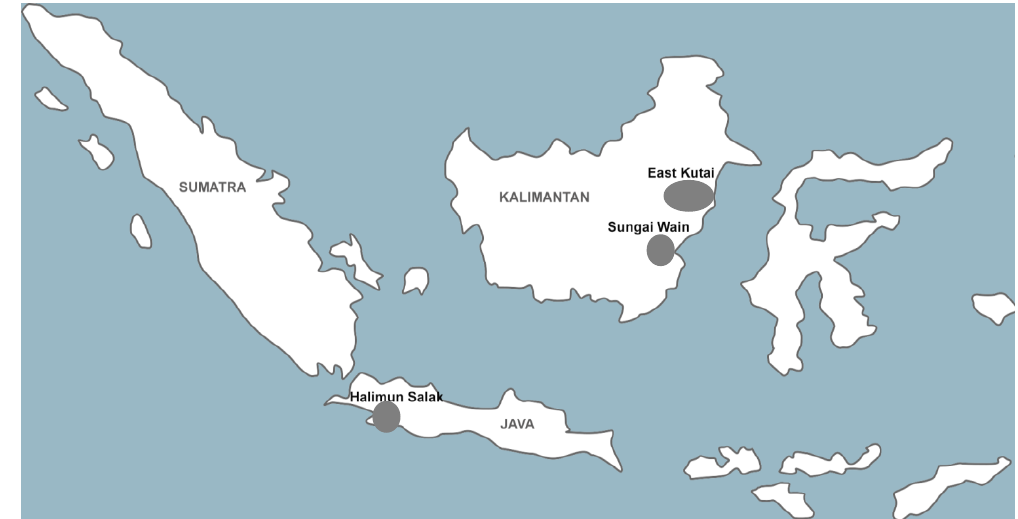
Figure 1. Location of the three case study areas in